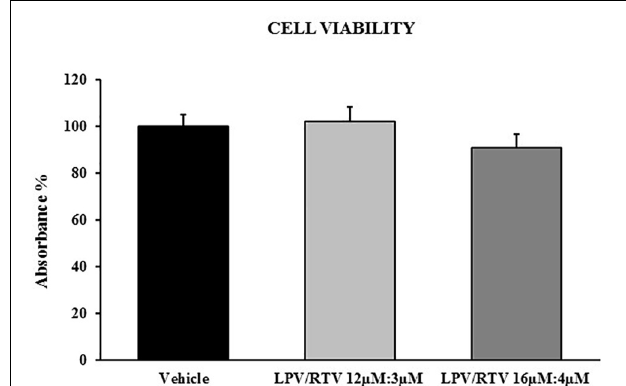
FIGURE 1 | Effect of LPV:RTV treatment on viability of differentiated 3T3-L1 cells. Fully differentiated 3T3-L1 cells were treated for 48 h with LPV:RTV (12 µ M:3 µ M, 16 µ M:4 µ M) or with vehicle alone. Absorbance was measured at 570 nm. The values of absorbance were expressed relatively to absorbance measured in the vehicle group. Results are expressed as mean ± SEM and represent the mean of 18 determinations per group, obtained in three independent experiments.